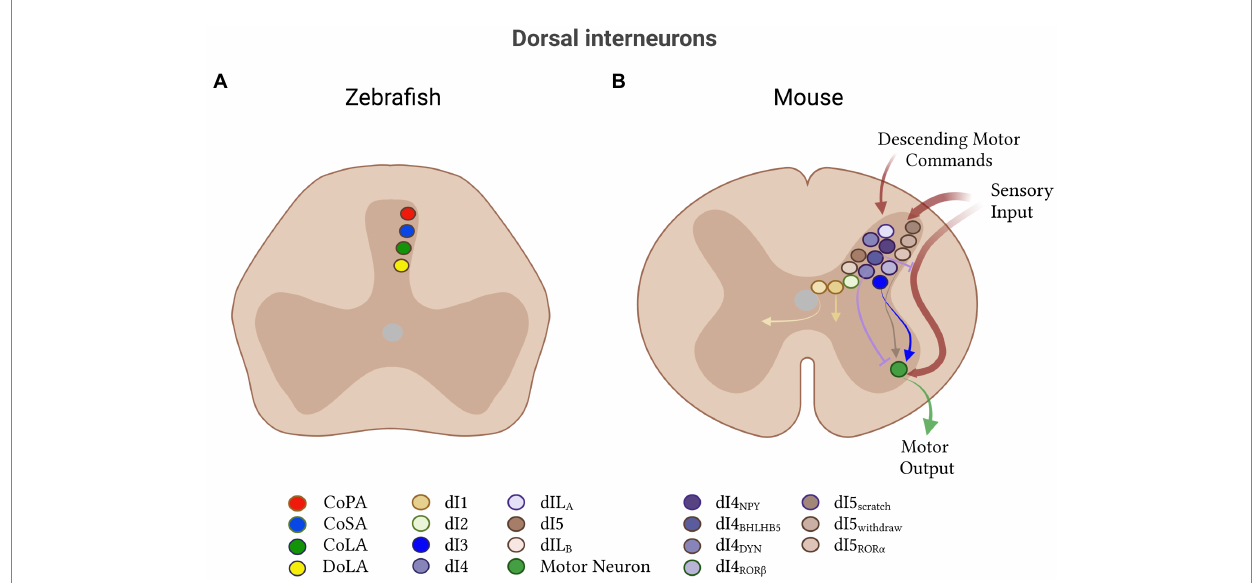
FIGURE 7 Other dorsal interneurons in zebrafish and mice. (A) In zebrafish, four classes of dorsal interneuron have been identified: glutamatergic commissural primary ascending (CoPA, red), glycinergic commissural secondary ascending (CoSA, dark blue), glycinergic commissural longitudinal ascending (CoLA, green), and glycinergic dorsal longitudinal ascending (DoLA, yellow). CoPA neurons drive touch-mediated larval escape. (B) In mice, dorsal neurons are divided into seven classes: dI1-5, dIL A and dIL B . The glutamatergic dI1 class (yellow) subdivides into ipsi- and contralateral populations. Little is known about the dI2 class (light green). The dI3 class (dark blue) receives cutaneous afferent input and excites motor neurons (green). The dI4 class subdivides according to sensory modality: the NPY subclass (dark purple) is associated with mechanical itch, BHLHB5 (medium-dark purple) with chemical itch, and DYN (medium-light purple) with nociception. ROR β neurons (light purple) gate sensory afferent transmission. They also include dIL A (light purple-pink) and dIL B (light pink-brown) classes. dI5 neurons associated with scratch (dark brown) are located in laminae I/II, and with paw withdrawal reflex (medium brown) in laminae II/III. ROR α neurons (light brown) receive descending motor commands and project onto motor neurons, and function in corrective motor